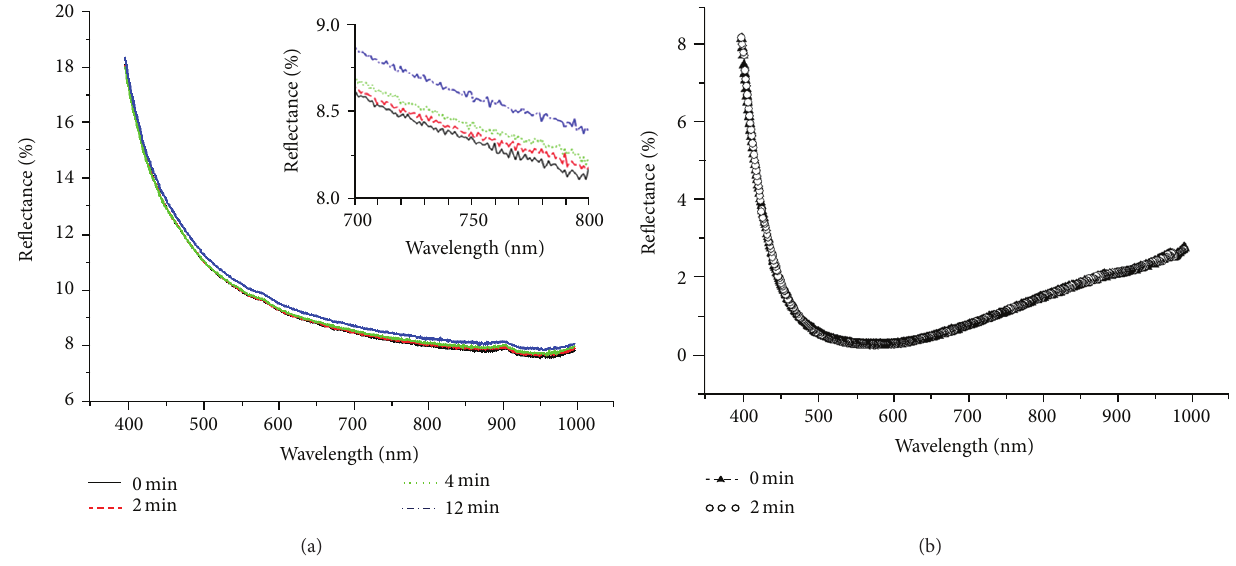
Figure 6: Optical reflectance versus wavelength for wafers (a) without ARC deposited and (b) with ARC deposited. The legends refer to the etching time, with 0 min denoting an as-textured wafer, that is, a wafer that does not go through an etch-back process.